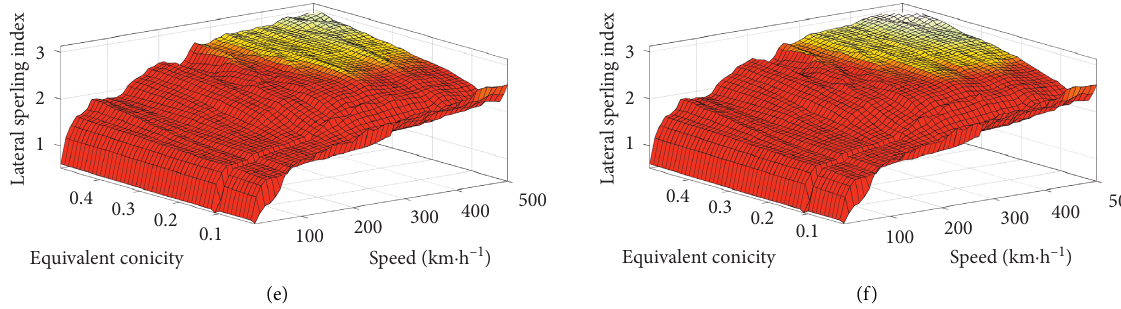
Figure 17: Vehicle ride quality space with joint stiffness of 25MN · m − 1 and additional stiffness of 8 MN · m − 1 . (a) c � 0. (b) c � 110kN · s · m − 1